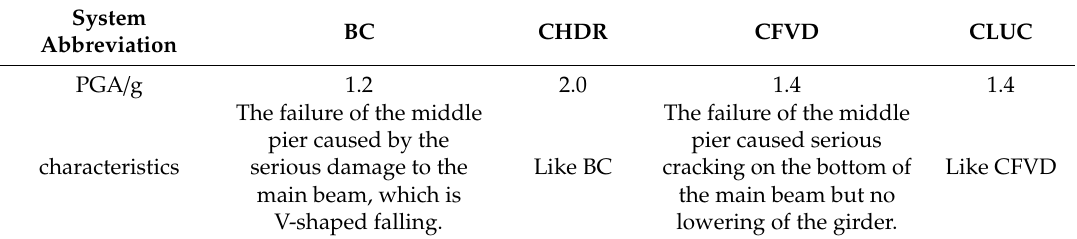
Table 6. Collapse characteristics of the El Centro seismic wave case.